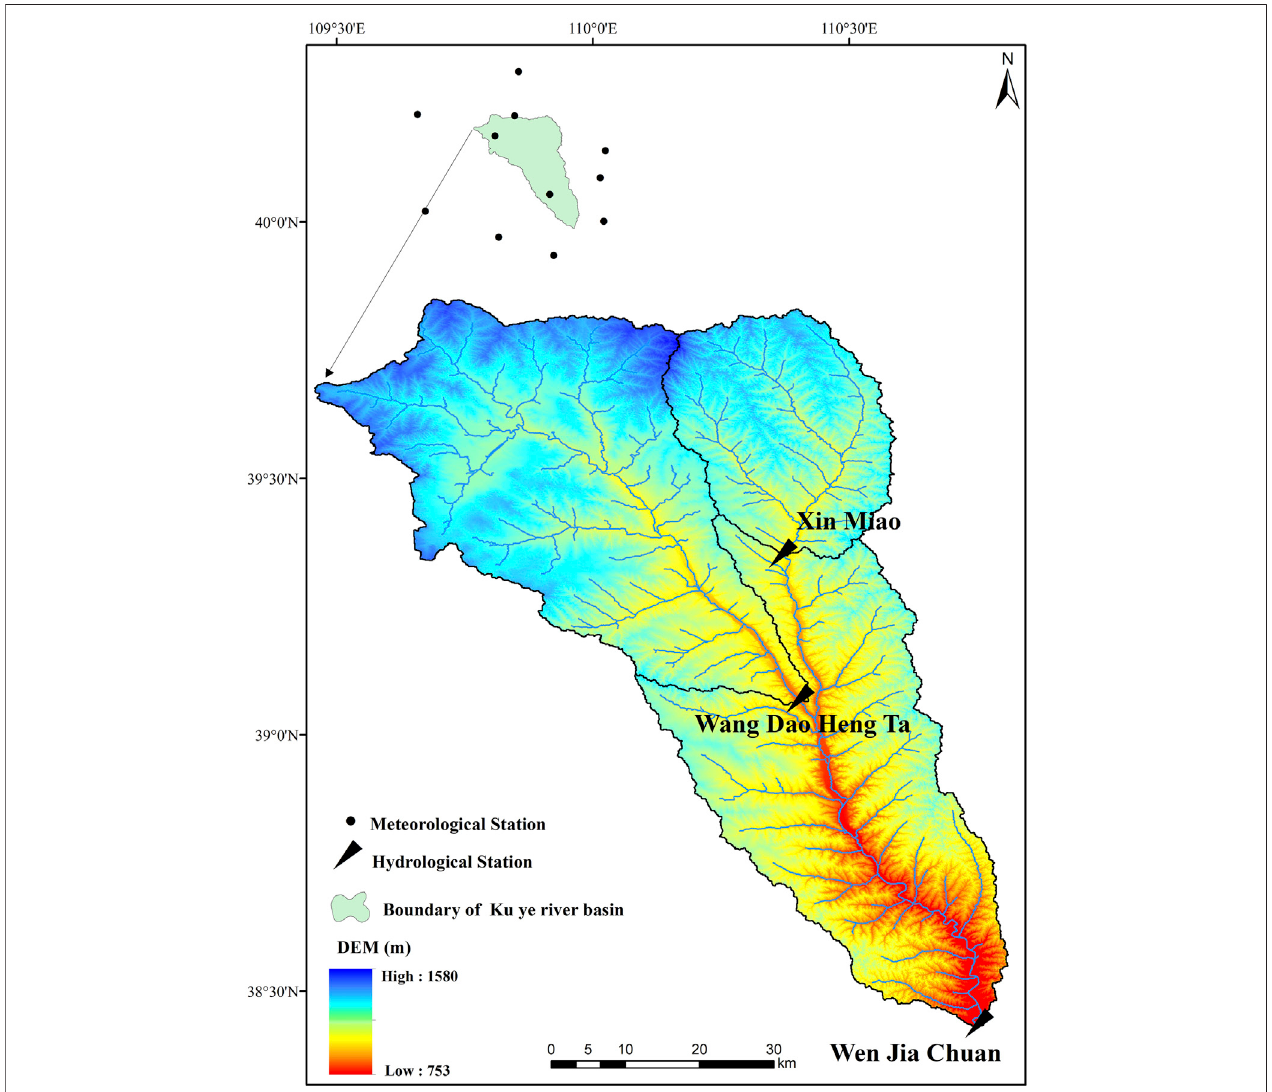
FIGURE 1 | The location of the Kuye River